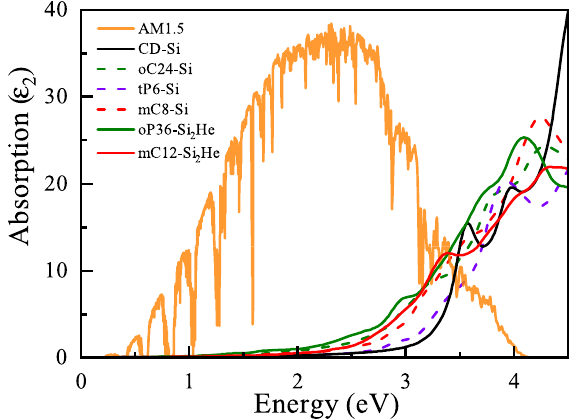
Fig. 7 Optical properties of the predicted Si 2 He and Si allotropes. Imaginary part of the dielectric functions of oP36-Si 2 He, mC12- Si 2 He, and the three silicon alltropes (oC24-Si, tP6-Si, and mC8-Si) calculated with the HSE06 functional, as well as the reference air mass 1.5 (AM1.5) solar spectral irradiance 62 and CD-Si.